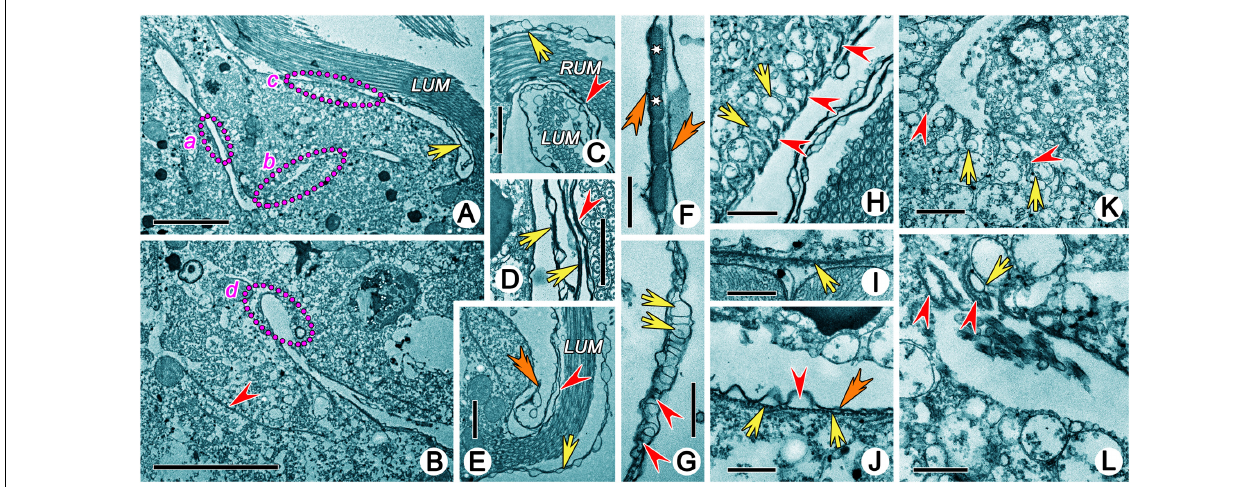
FIGURE 6 | Transmission electron micrographs showing structures in buccal field of Uronychia binucleata . (A,B) Longitudinal section of buccal field, showing the large cytopharyngeal apparatus which extended into cytoplasm as a narrow L-shaped cavity. Areas marked “a” “b” “c” and “d” are enlarged in (J,K,H,L) , respectively. Arrow marks the rootless membrane structure beneath the left component of the undulating membrane, arrowhead points to the microtubules sheet beneath the cytopharyngeal apparatus. (C,E) Base of right (C) and left (E) components of the undulating membrane, to show the membrane structures around it extending from plasmalemma of dorsal wall (arrowhead) and cell surface (arrow). Double-arrowhead points to the rootless membrane structure. (D) Longitudinal section of membrane structures. Arrowhead indicates membrane structure inside of left component of the undulating membrane, arrows point the rootless membrane structures. (F,G) The membrane structure contains numerous small cytoplasmic vesicles (arrows), microtubules (arrowheads) and extrusomes (asterisk) and is bounded by the plasmalemma (double-arrowheads). Flattened pharyngeal disks (arrows) situated in the dorsal wall of the buccal cavity (H) , at the innermost end (K) and bottom corner of cytopharyngeal apparatus (L) . Arrowheads point to the microtubular sheets interposed between them. (I) Microtubules sheet (arrow) located beneath the cytopharyngeal apparatus. (J) Cytopharyngeal apparatus contains plasmalemma (double-arrowhead), alveoli (arrowhead) and subpellicular microtubules (arrow) without pharyngeal disks. LUM, left component of the undulating membrane; RUM, right component of the undulating membrane. Scale bars = 5 µ m (A,B) , 2 µ m (C,E) , 1 µ m (D,H,K) , 0.5 µ m (F,G,I,L)